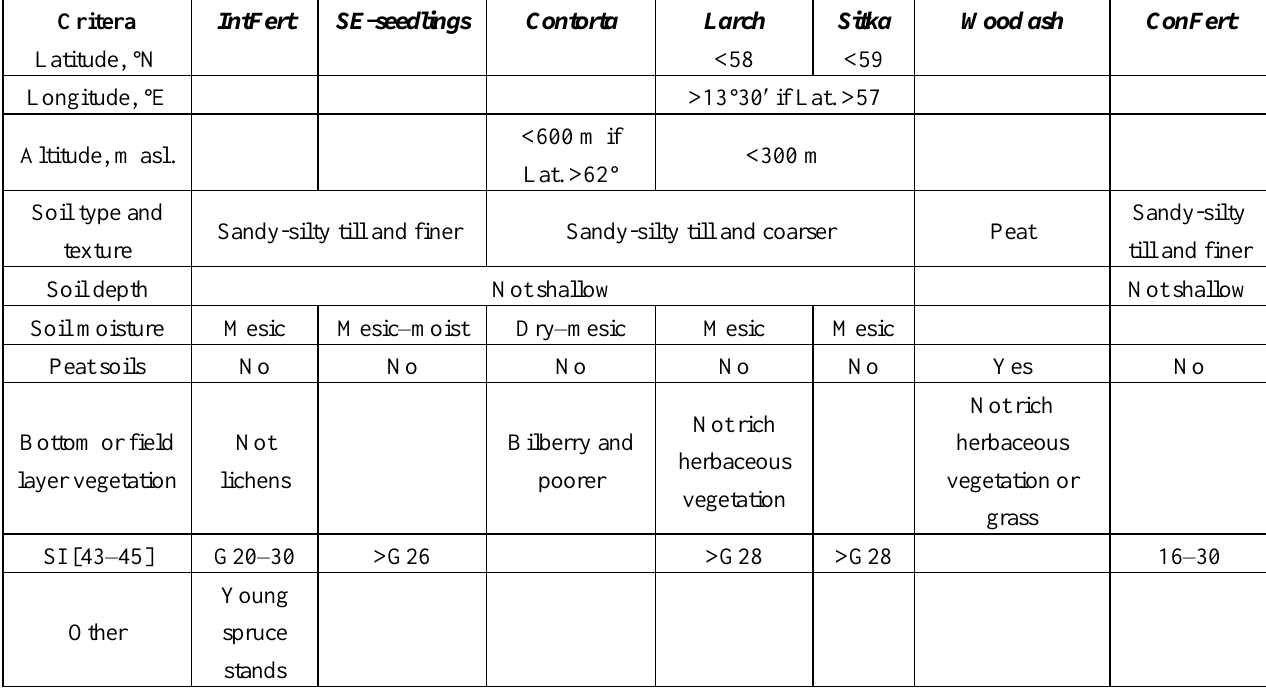
Table 3. Site properties and stand criteria for selecting stands for intensive forest management (IFM)